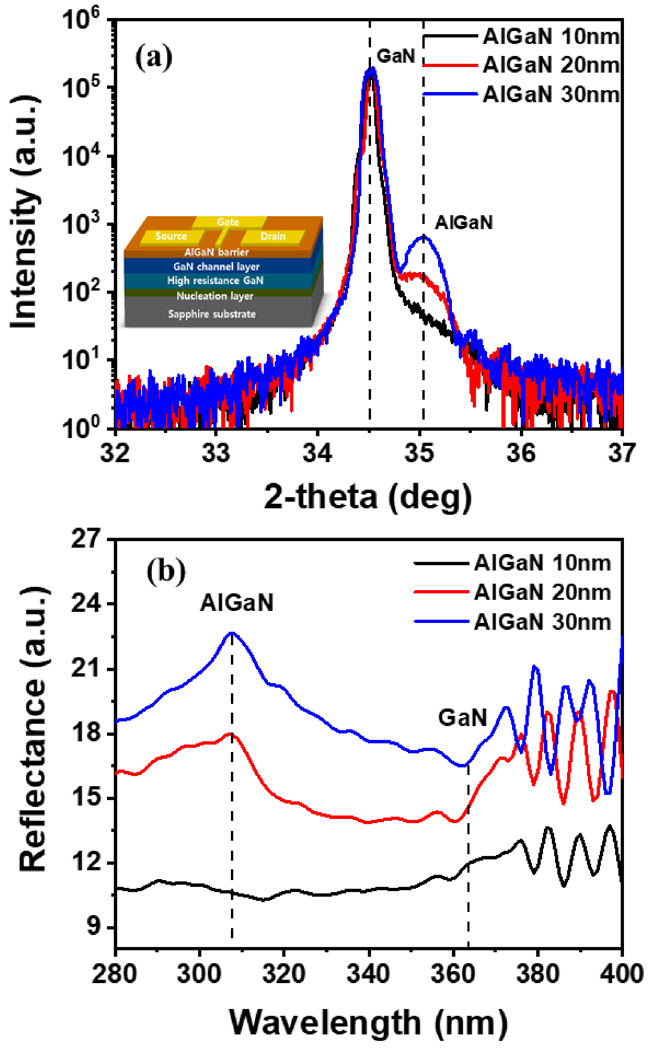
Figure 1. Structure and optical properties of AlGaN/GaN HEMTs with different AlGaN barrier thicknesses characterized using X-ray (002) ω/2θ scans ( a ) and optical reflectance analysis ( b ). The inset shows a schematic of the AlGaN/GaN HEMT with the source, drain, and gate